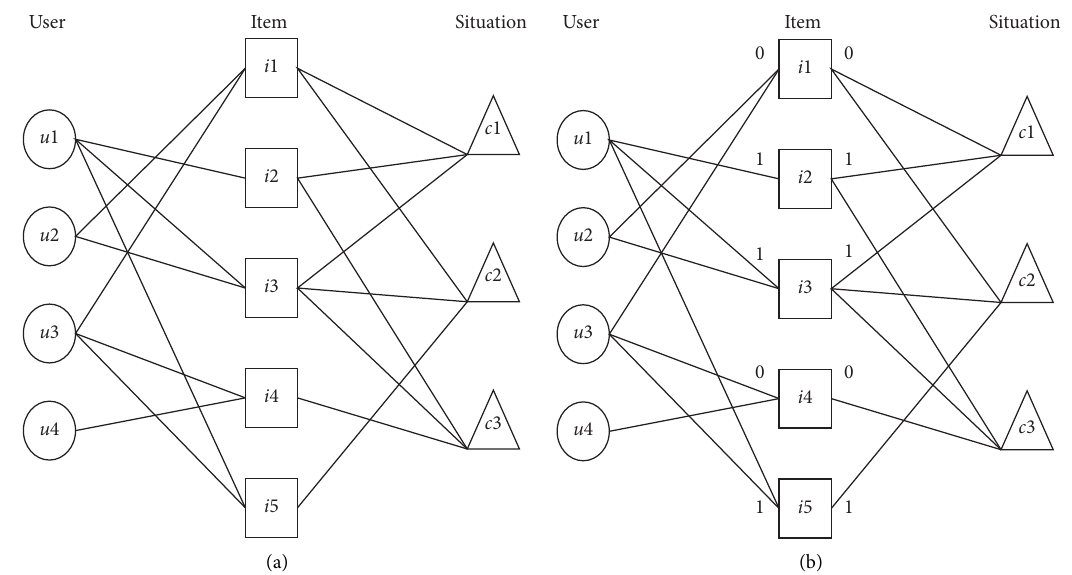
Figure 3: Processing of the tripartite graph model based on mass